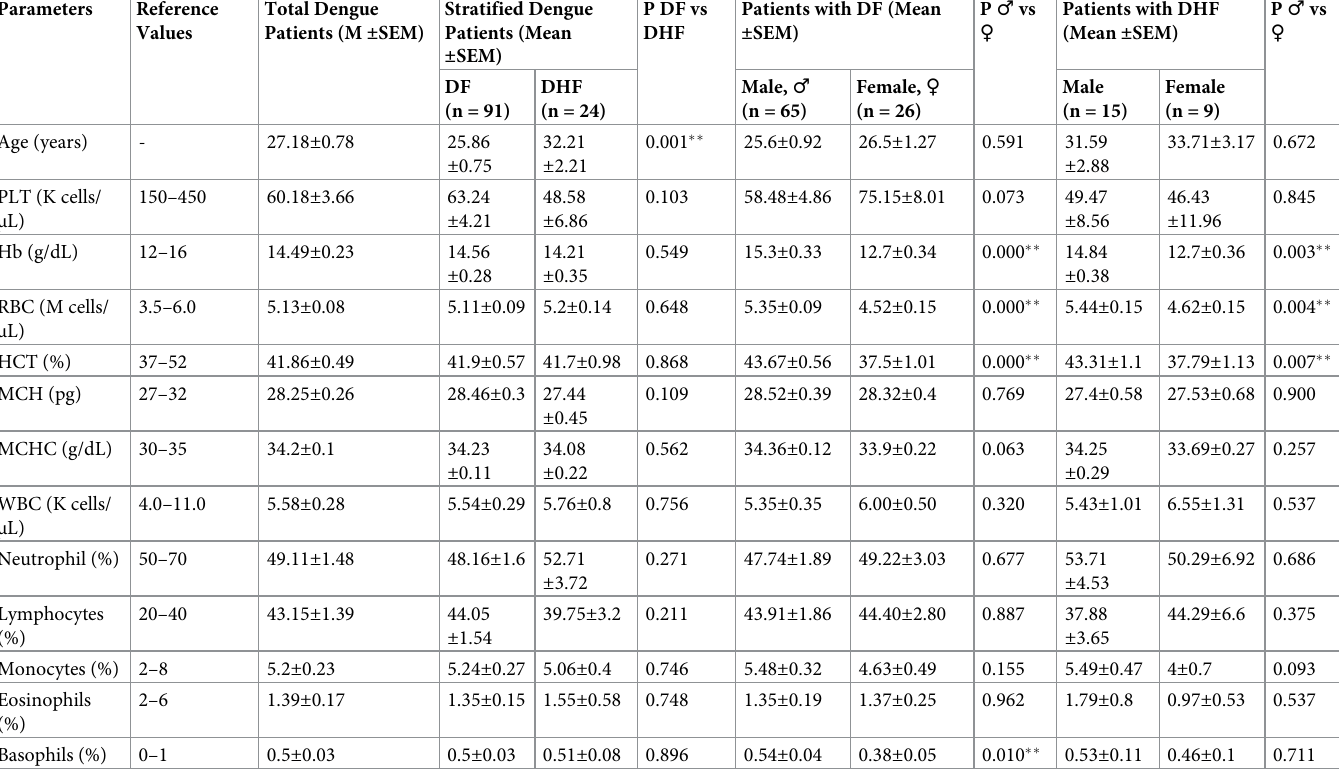
Table 1. Comparison of blood parameters between dengue patients with dengue fever (DF) and dengue hemorrhagic fever (DHF).